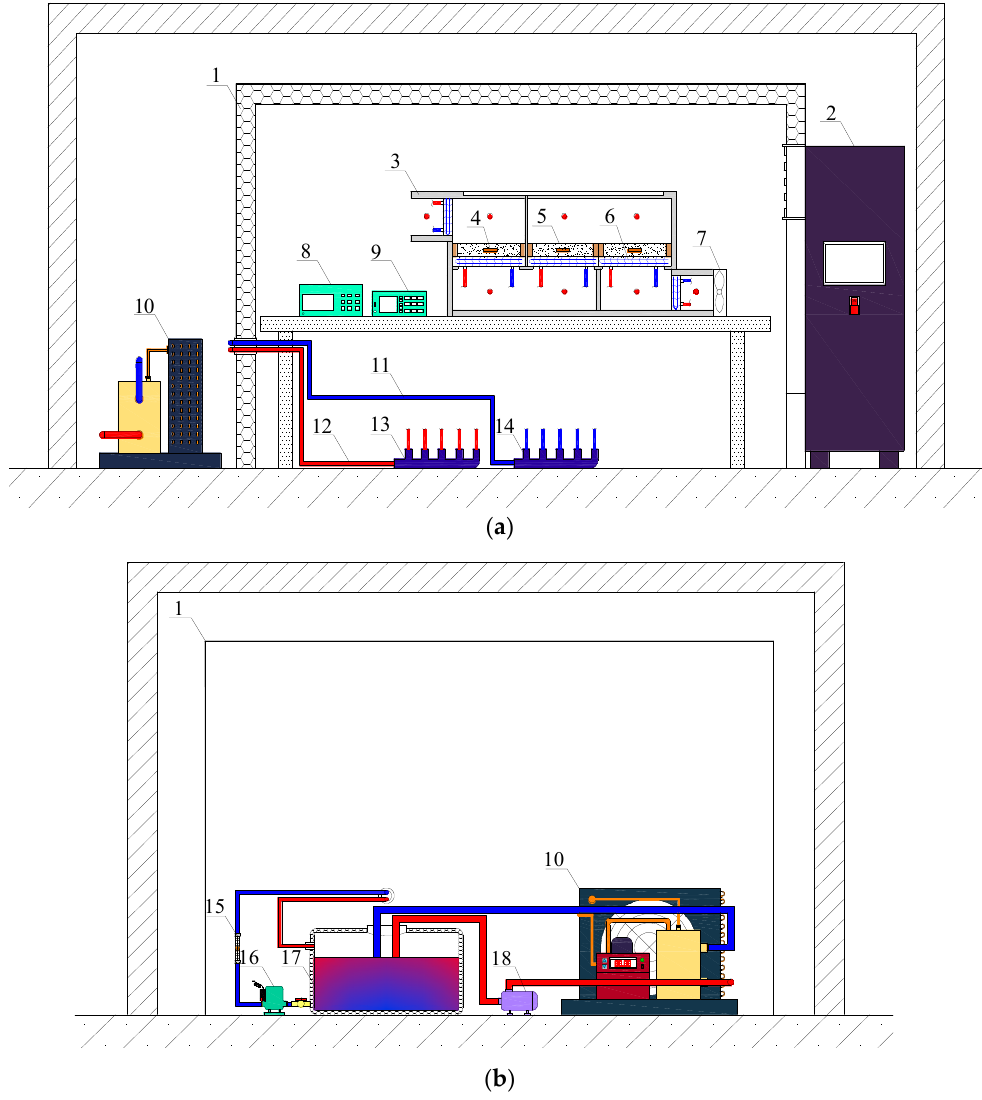
Figure 2. Images of the test rig: ( a ) the front view; ( b ) the left view: 1—Environmental cabinet;